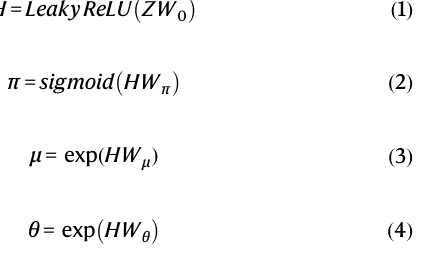
microglia in the cortexof the 8-months samples(normalizedto sum to 1, since the proportion of microglia increases in AD; see inset). Red line: threshold of hetero- chromatinpixels(seeMethods). f Distributionofheterochromatinratioofeachcell typeincluster3of13-monthscontrolandADsamples.* p -value<0.05forcontrolvs ADsamples.Cells are from two micewith atleast 7766 cellseach. Boundsofboxes indicatequartiles.Whiskersindicateextrema.Two-sided T -testsareperformedand raw p-values are 8.715e − 9 (Astro), 0.07304 (DG), 2.705e − 8 (Endo), 1.380e − 41 (Ex), (SMC). g Heterochromatin ratio versus log 2 average gradient of cells in the cortex of the 8-months AD sample colored by cortex cluster membership. Red line fi tted usinglinearregression. P -valuesarecalculated bytwo-sided Wald Testandthe null hypothesisthattheslopeis0.Exexcitatoryneuron,Micromicroglia,Inhiinhibitory neuron, Endo endothelial cell, Astro astrocytes, OPC oligodendrocyte precursor cell, SMC smooth muscle